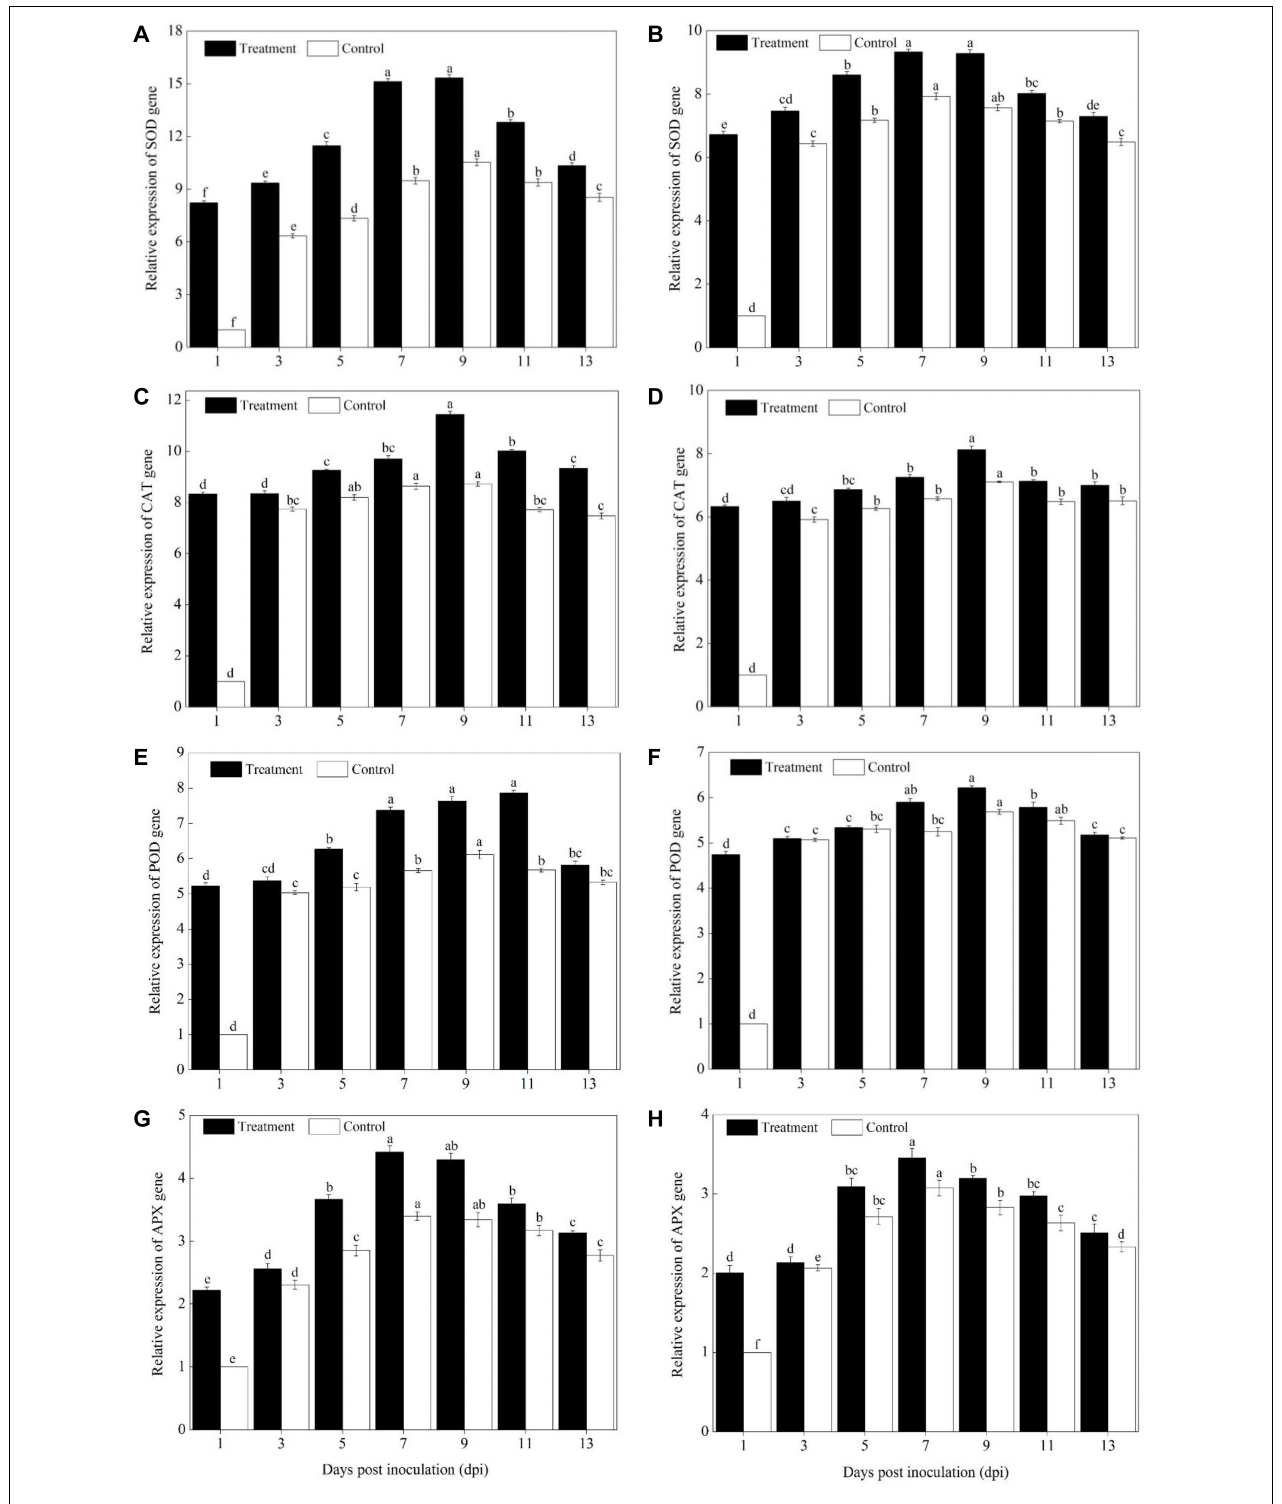
FIGURE 5 | Expression levels of ROS scavenging enzyme genes in the leaves of Sixing F 1 and Jin 12 F 1 at different time points after being inoculated with Podosphaera xanthii. (A,C,E,G) The expression levels of SOD , CAT , POD , and APX genes in Sixing F 1 , respectively; (B,D,F,H) the expression levels of SOD , CAT , POD , and APX genes in Jin 12 F 1 , respectively. The line bars, different letters, and treatments are detailed in the footnote of Figure 2 and Table 2 .